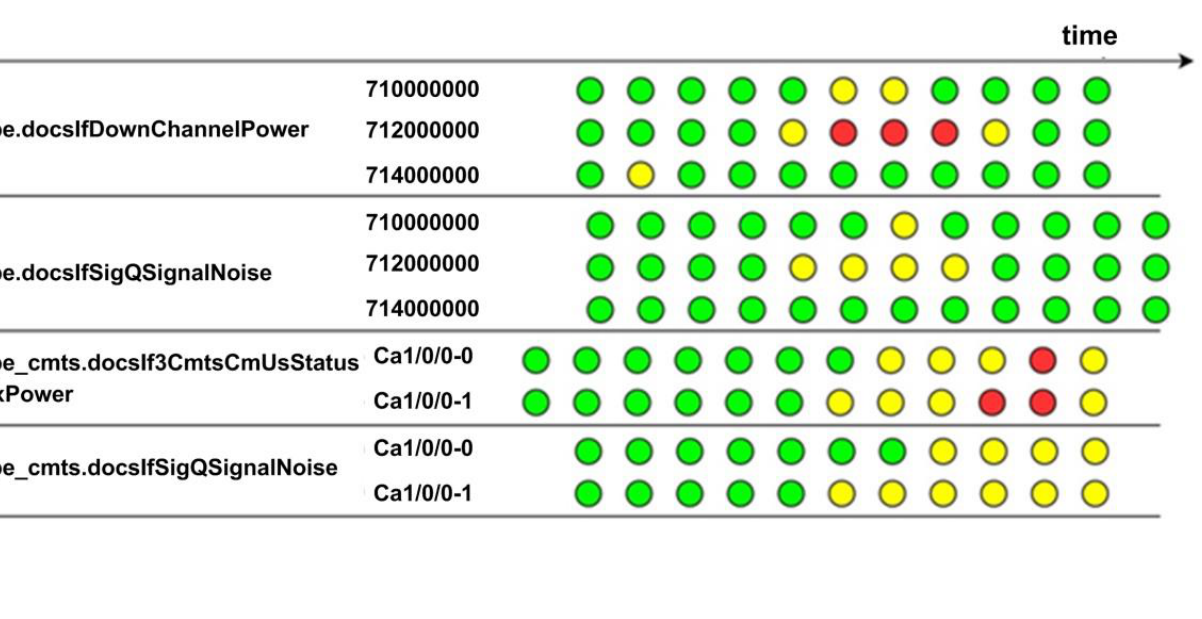
Table 4. Mapping of performance metrics onto the unified grade scale.